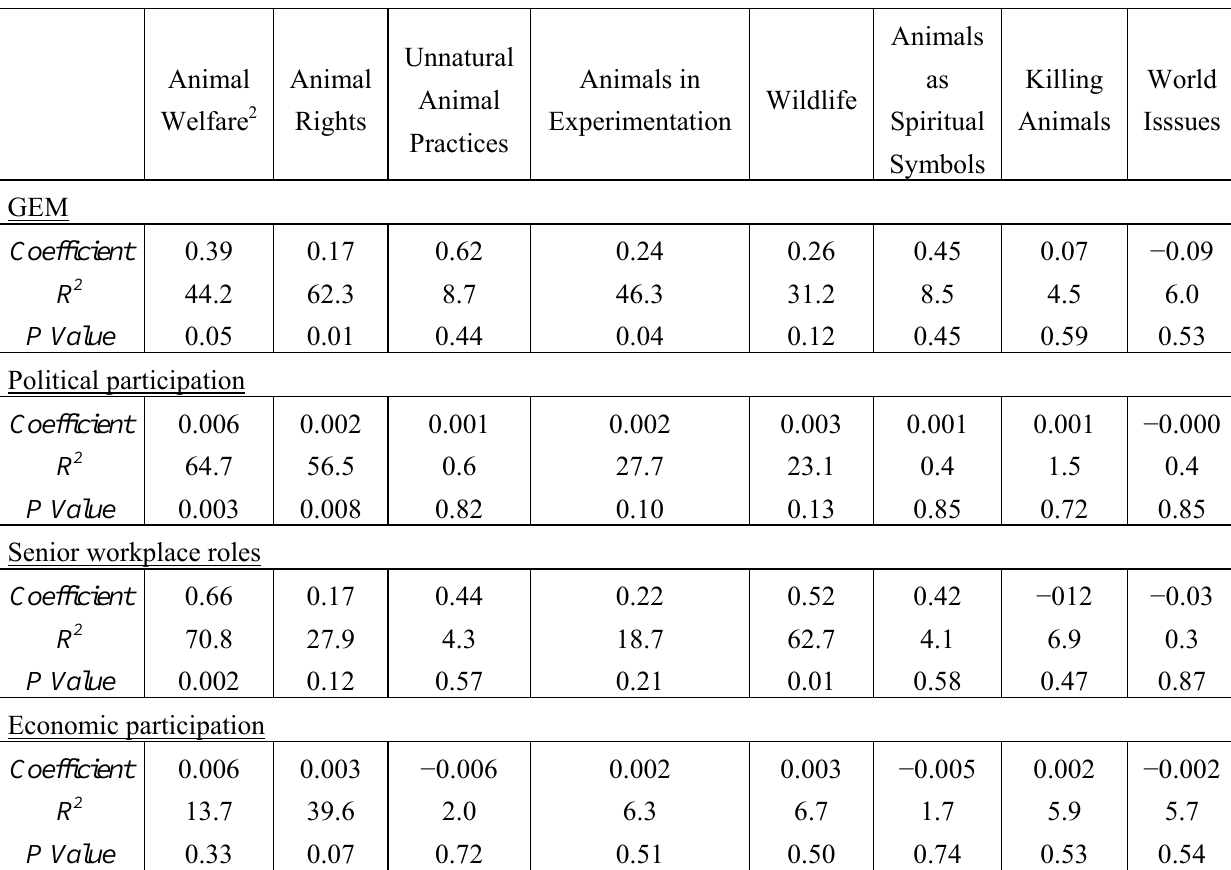
Table 5. Relationship between the Gender Empowerment Measure, and its components of Political participation, Senior workplace roles and Economic participation, and the ratio of female to male scores for the indices for Animal Welfare, Animal Rights, Unnatural Practices on Animals, Killing Animals, Animals in Experiments, Wildlife, Using Animals as Spiritual Symbols and World Issues for each